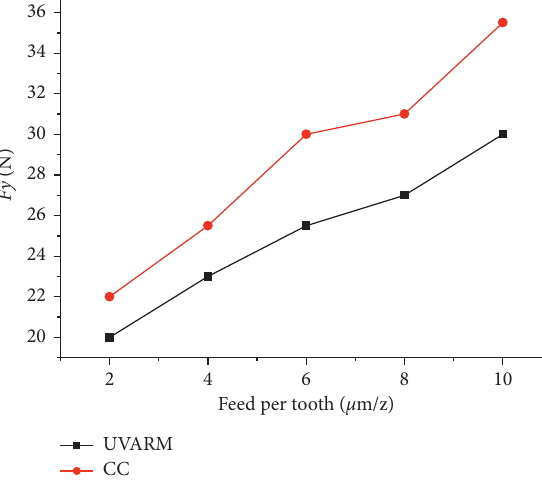
Figure 14: Fy changes with feed per tooth.